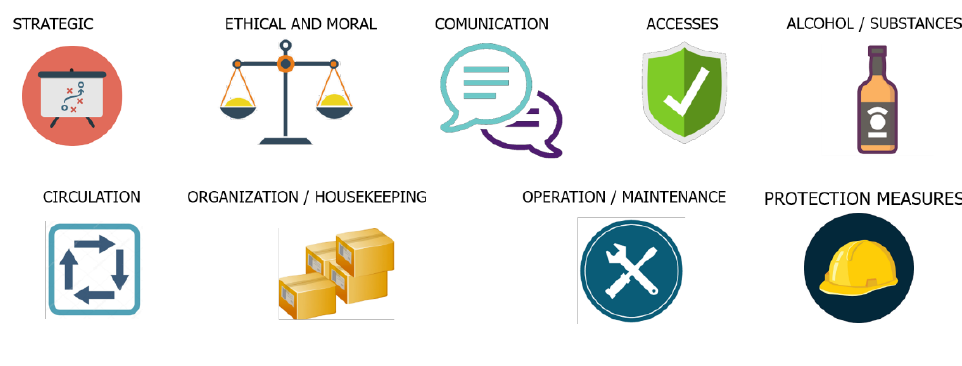
Figure 4. SSP Classification